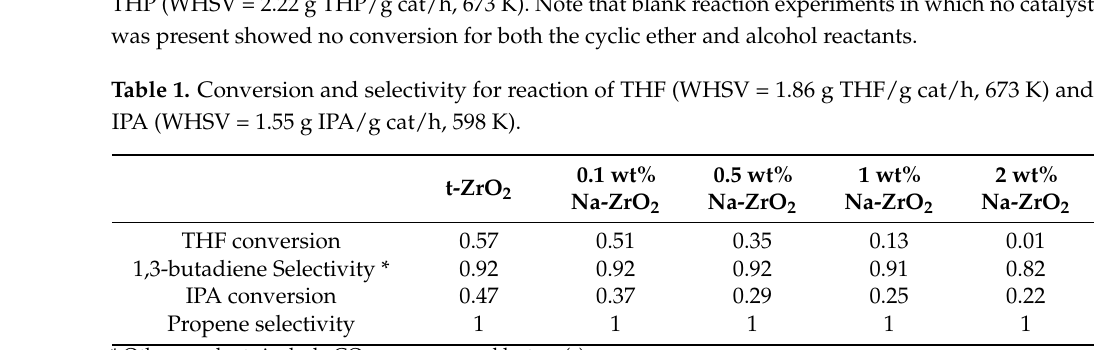
Figure 1. ( a ) Conversion as a function of Na loading for the reaction of isopropanol (IPA) (WHSV = 1.55 g IPA/g cat/h, 598 K) and THF (WHSV = 1.86 g THF/g cat/h, 673 K) on ZrO 2 as a function of the Na loading. ( b ) Analogous data for the reaction of 4P1OL (WHSV = 2.22 g 4P1OL/g cat/h, 673 K) and THP (WHSV = 2.22 g THP/g cat/h, 673 K). Note that blank reaction experiments in which no catalyst